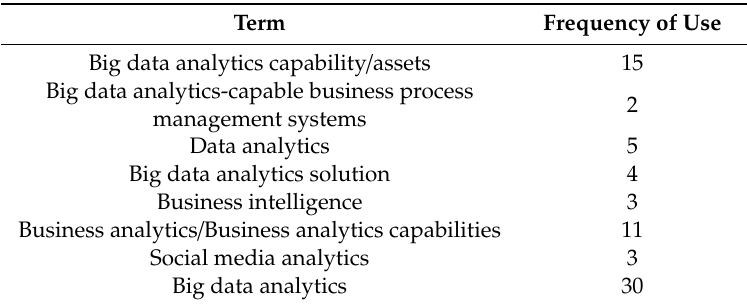
Table 4. Frequency of terms